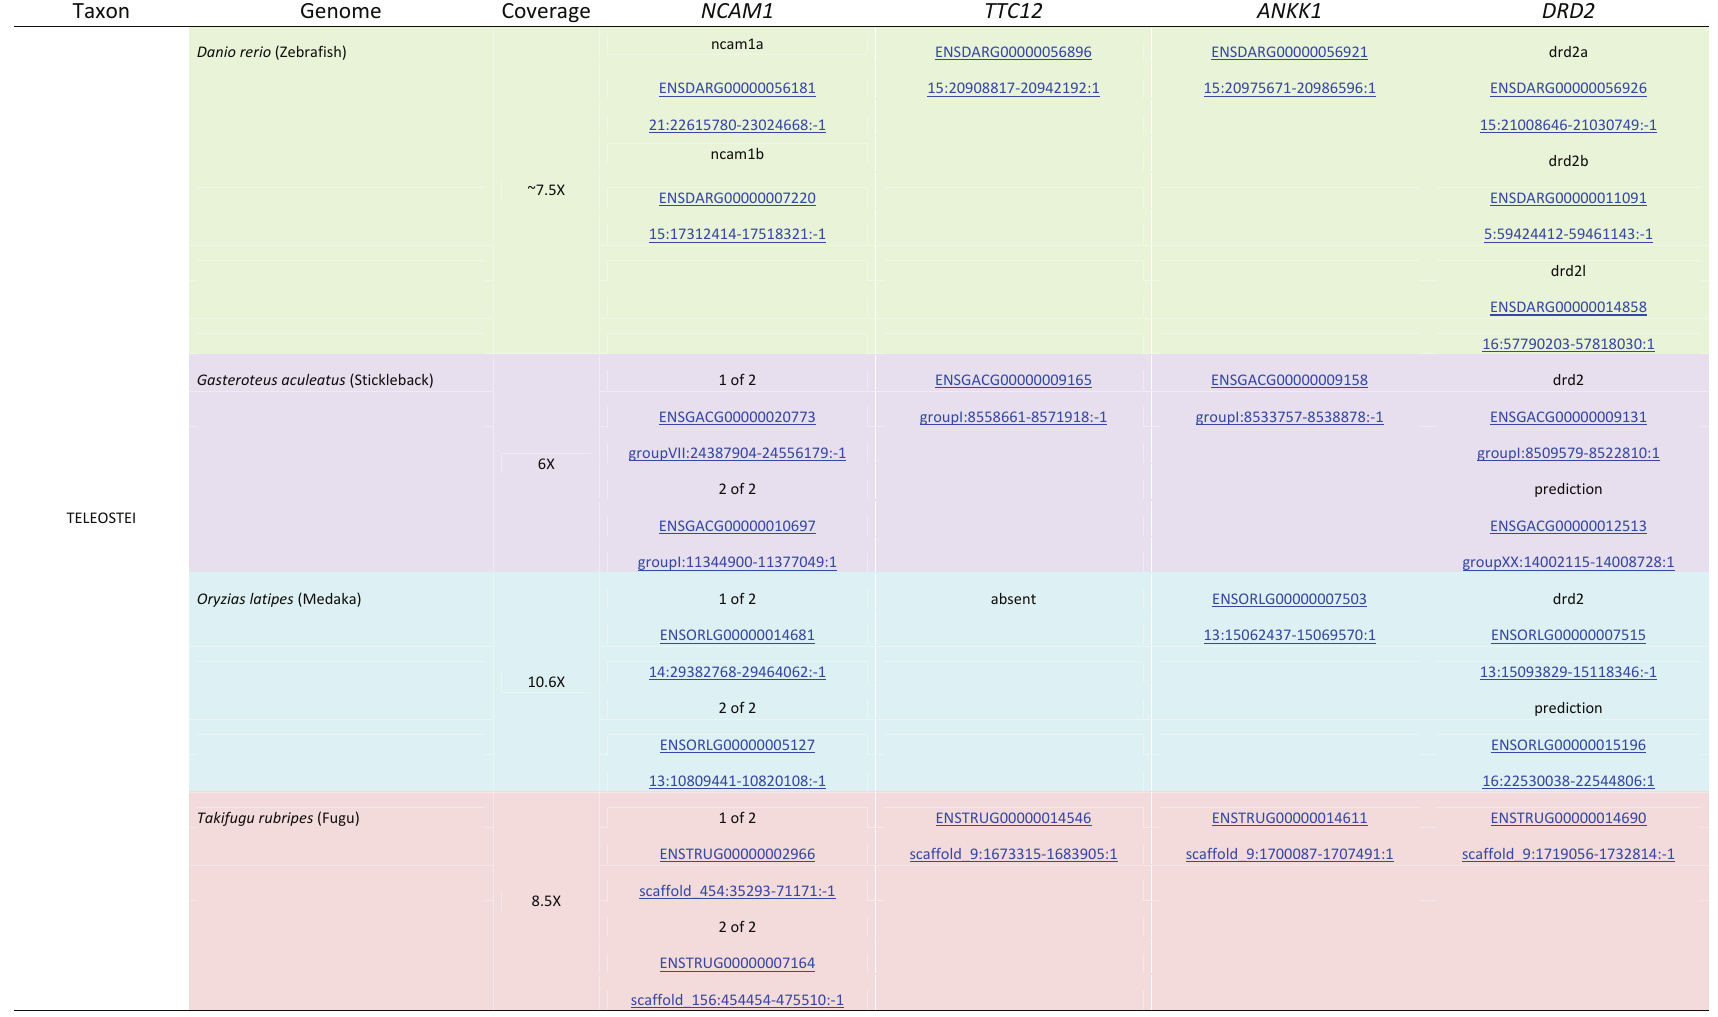
Table S1. Orthologues of genes in the NTAD cluster in 47 available vertebrate genomes, showing accession number and location.